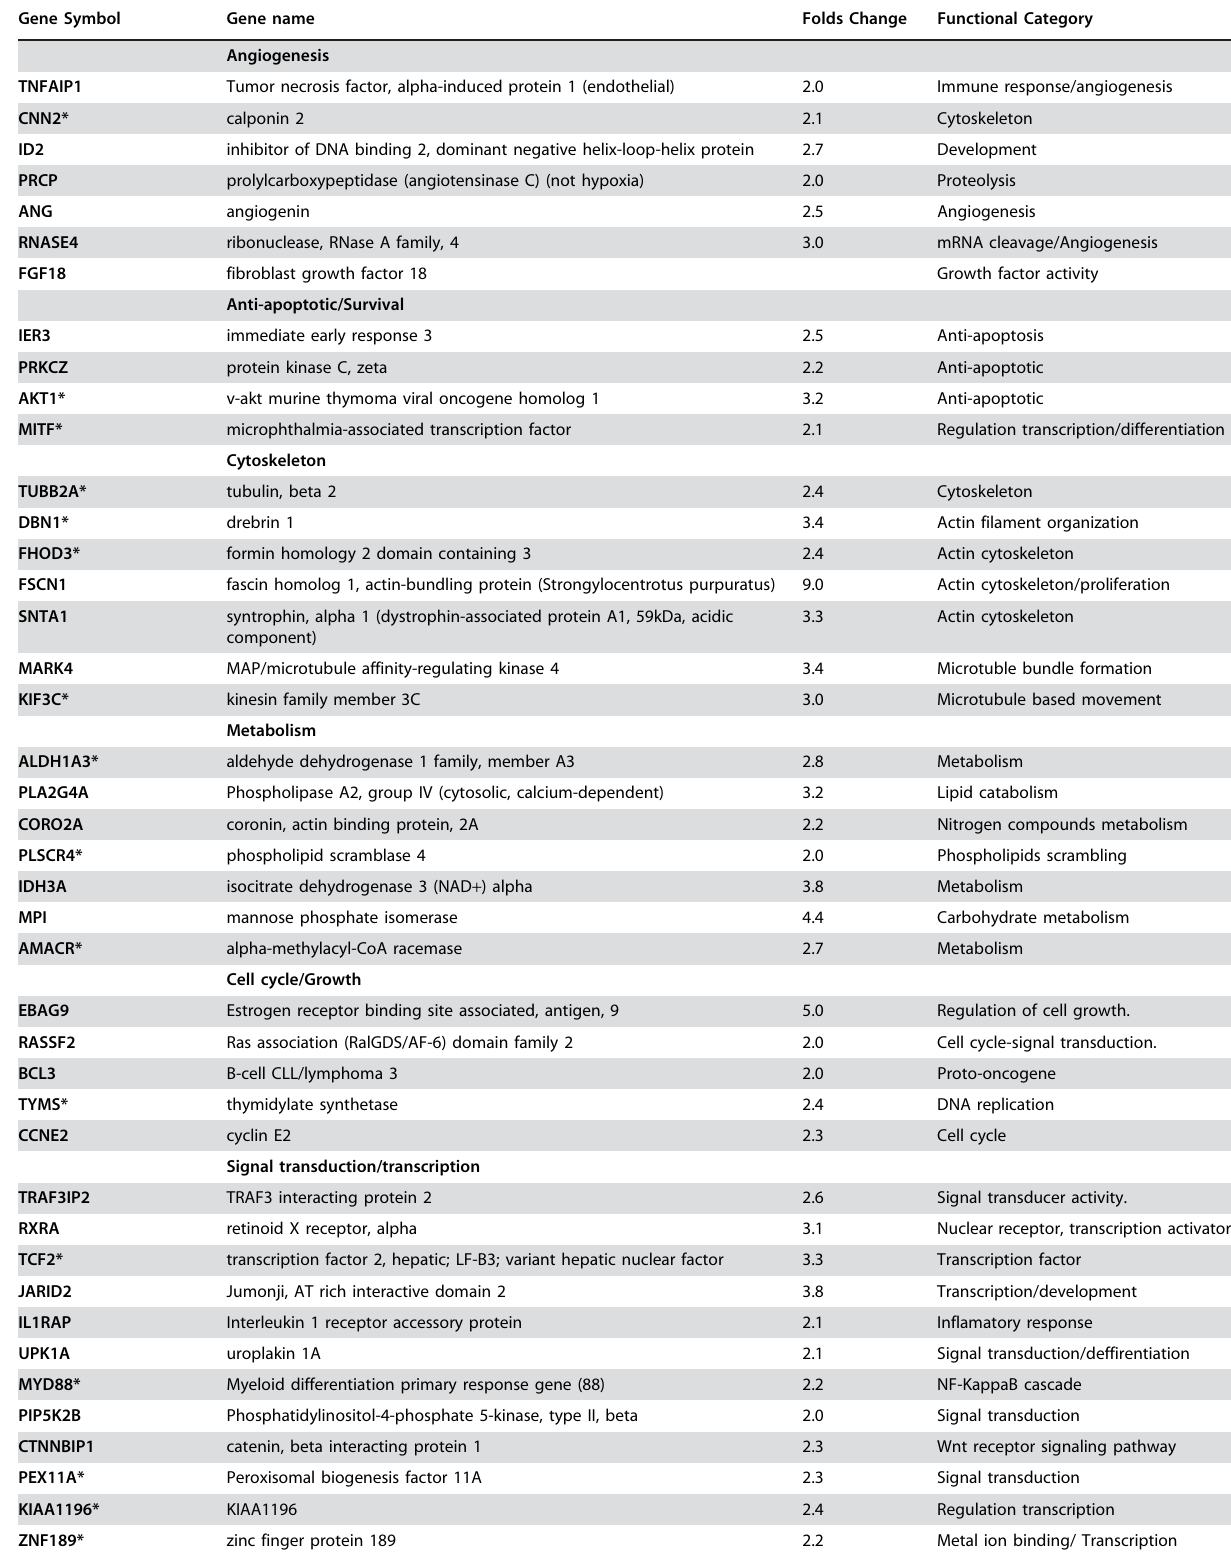
Table 1. Genes reduced by at least two-folds by H19 knockdown in hypoxic stress. .. ... .... ... ... .... ... ... .... ... ... .... ... ... .... ... ... .... ... ... .... ... ... .... ... ... .... ... ... .... ... ... .... ... ... .... ... ... .... ... ... .... ... ... . Gene